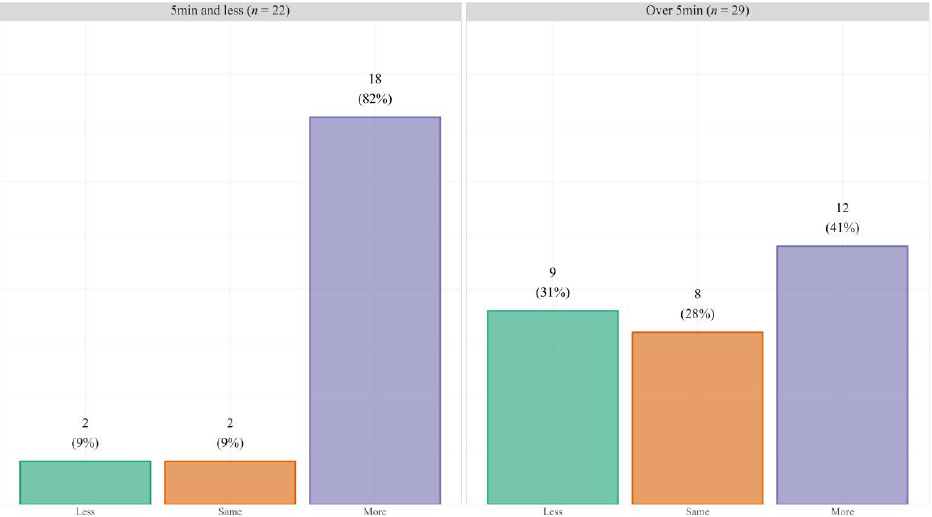
Figure 8. Respondents’ respective walking distance from Tanera Park and their change in frequency of park visits during the COVID-19 lockdowns in